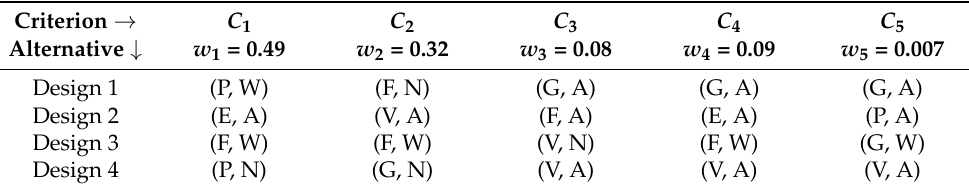
Figure 8. Conceptual design of four kinds of waste containers in the kitchen. ( a ) Design 1 ( b ) Design 2 ( c ) Design 3 ( d ) Design 4. Table 4. Decision matrix.